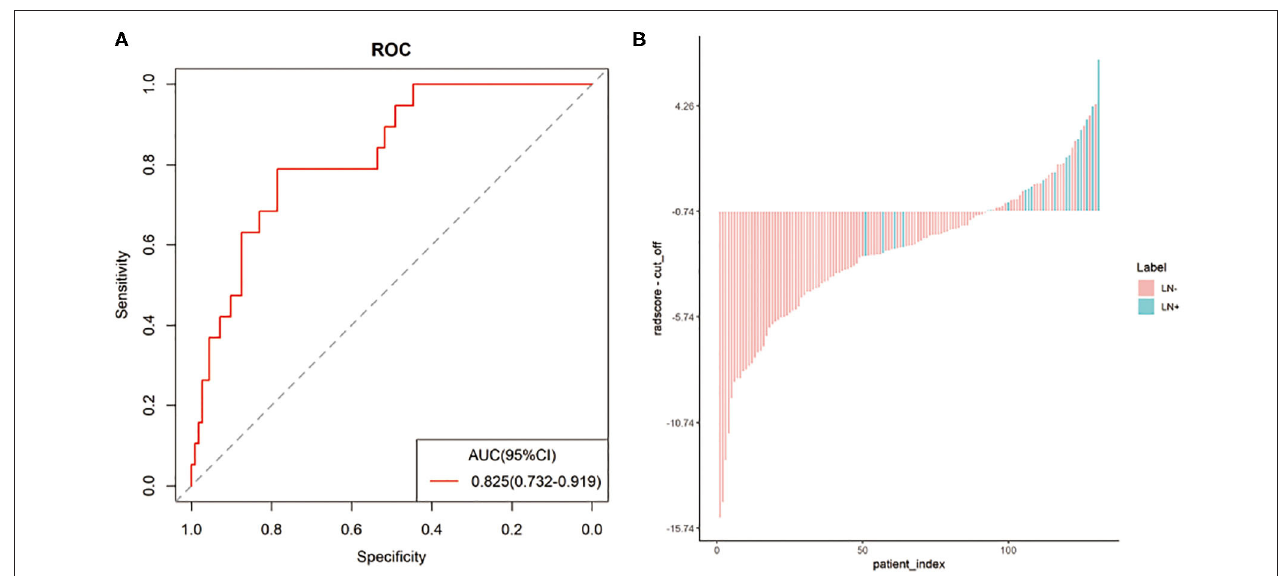
FIGURE 4 | The predictive performance of the radiomics signature in the MRI-reported LN-negative subgroup. Plots (A,B) show the ROC curve of the radiomics signature and the Rad-score of individual patients in the MRI-reported LN-negative